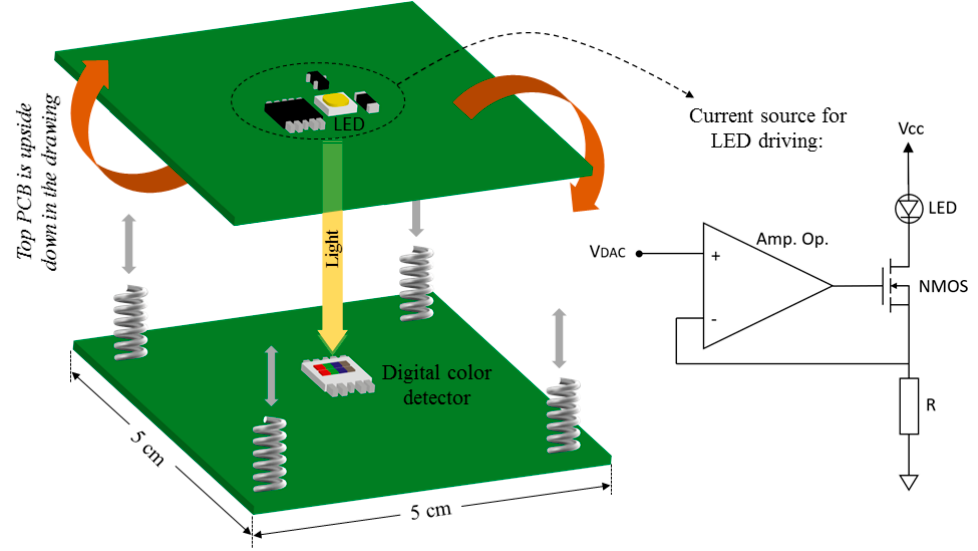
Figure 2. Sensing module and schematic of the current source.